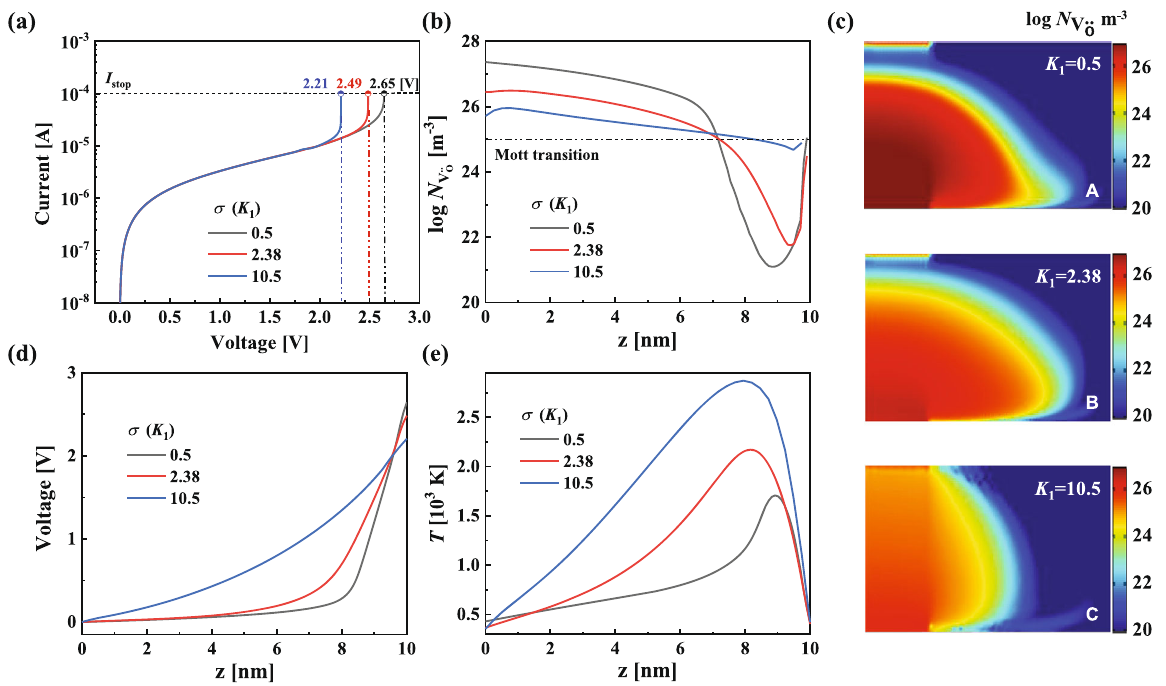
Fig. 4 Effect of electrical conductivity on the CF growth. a Current characteristic with different electrical conductivity (by K 1 ) under a voltage distributions along the center of CF ( x = 0, z = 0 – 10 nm) at fi nal state. c Calculated 2D N V :: sweep rate d V /d t = 1 V s − 1 . b N V :: o d , e Calculated 1D pro fi les of local electrical potential φ and temperature T along the center of CF ( x = 0, z = 0 – 10 nm) at fi nal state.